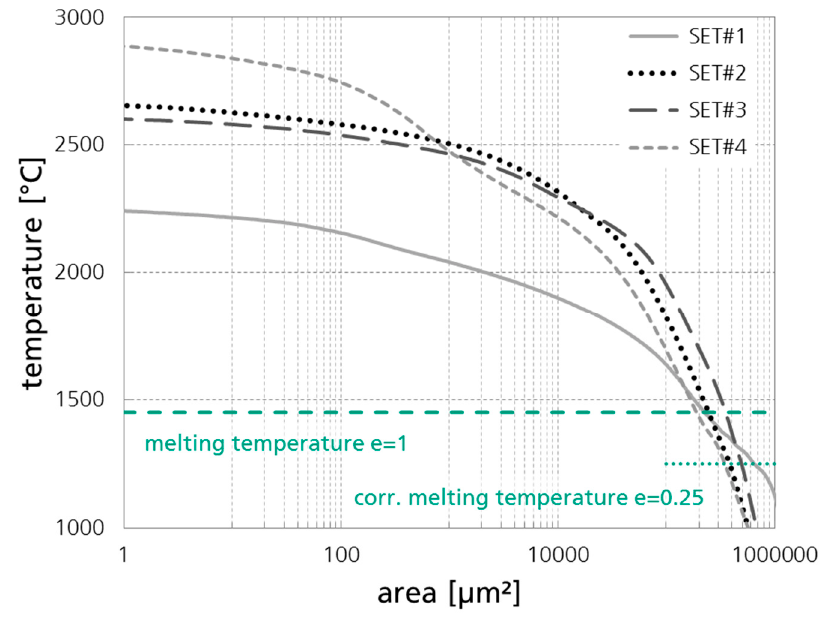
Figure 19. Global histogram of the temperature distribution, averaged for a period of 500 ms of 12 mm stainless steel cut with static beam shaping (set #1) and different values of the longitudinal, linear beam oscillation: 300 µm amplitude and 500 Hz frequency (set #2), 550 µm amplitude and 500 Hz frequency (set #3), 300 µm amplitude and 2000 Hz frequency (set #4).